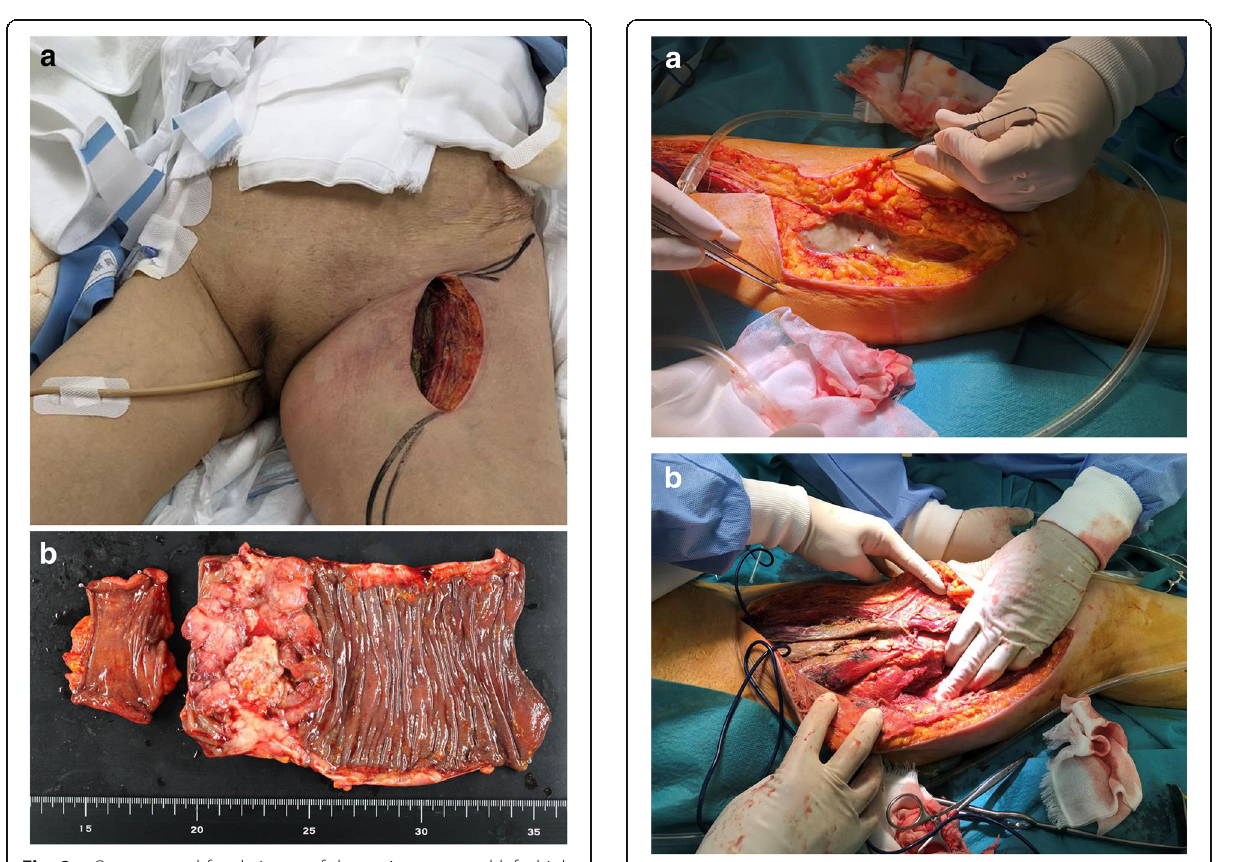
Fig. 2 a Open wound for drainage of the peritoneum and left thigh. b Surgical resected specimen of left hemicolectomy revels that tumor invades into the serosa (T4a) with no regional lymph node metastasis (N0)